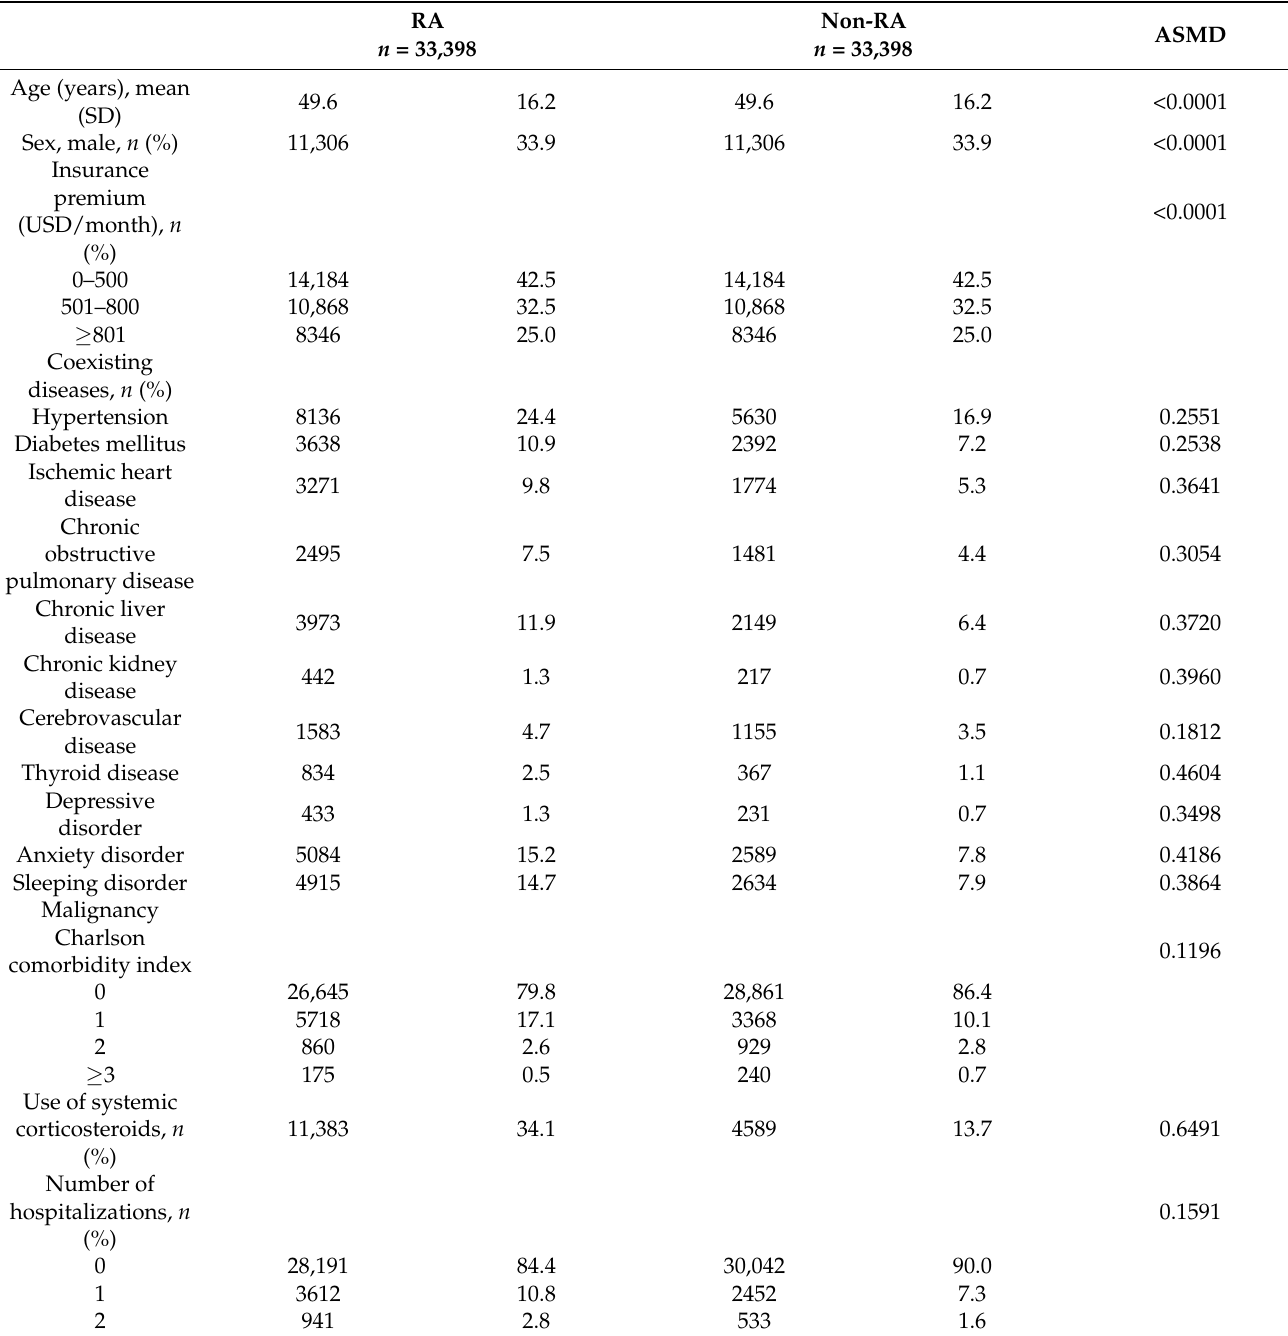
Table 1. Baseline characteristics of patients with and without rheumatoid